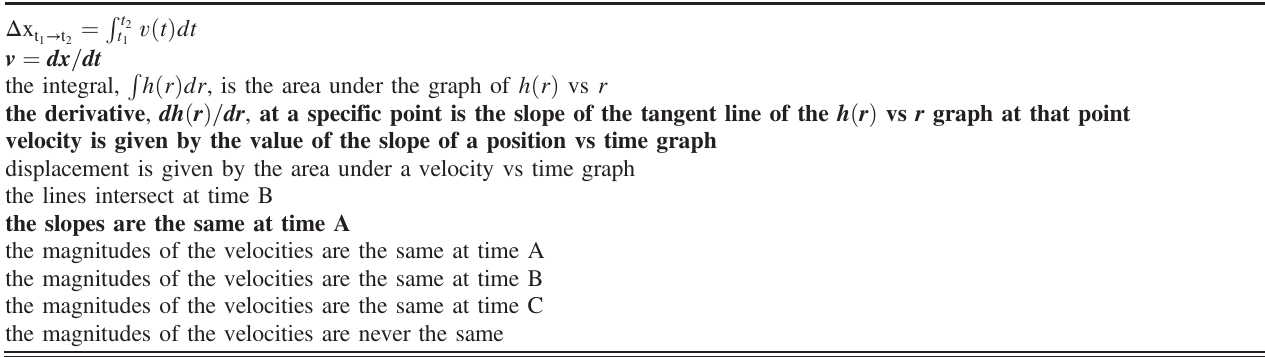
TABLE I. Reasoning elements provided to the students on the kinematics graph task. Elements productive to the correct line of reasoning (i.e., elements that support a correct model) are